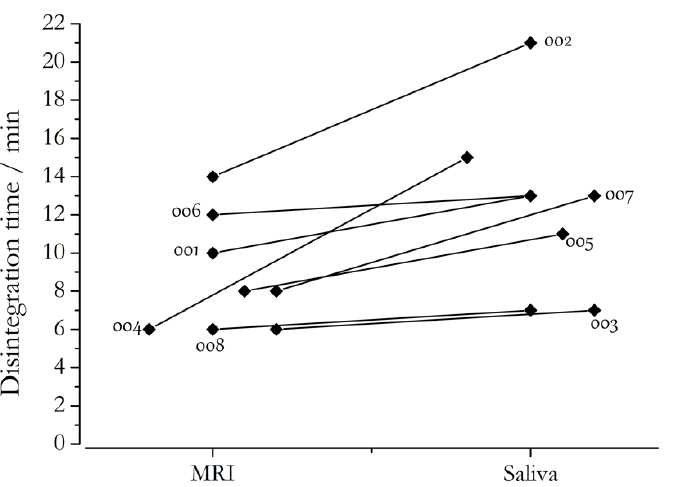
Figure 12. In vivo disintegration times of hard gelatin capsules that were labeled with 5 mg of black iron oxide and 50 mg of caffeine, as determined by MRI and the STT. Numbers indicate a single volunteer. Adapted from Molecular Pharmaceutics ., 16, Sager et al., “Combined Application of MRI and the Salivary Tracer Technique to Determine the in Vivo Disintegration Time of Immediate Release Formulation Administered to Healthy, Fasted Subjects” 1782–1786 (2019) [62], Copyright American Chemical Society (2019).